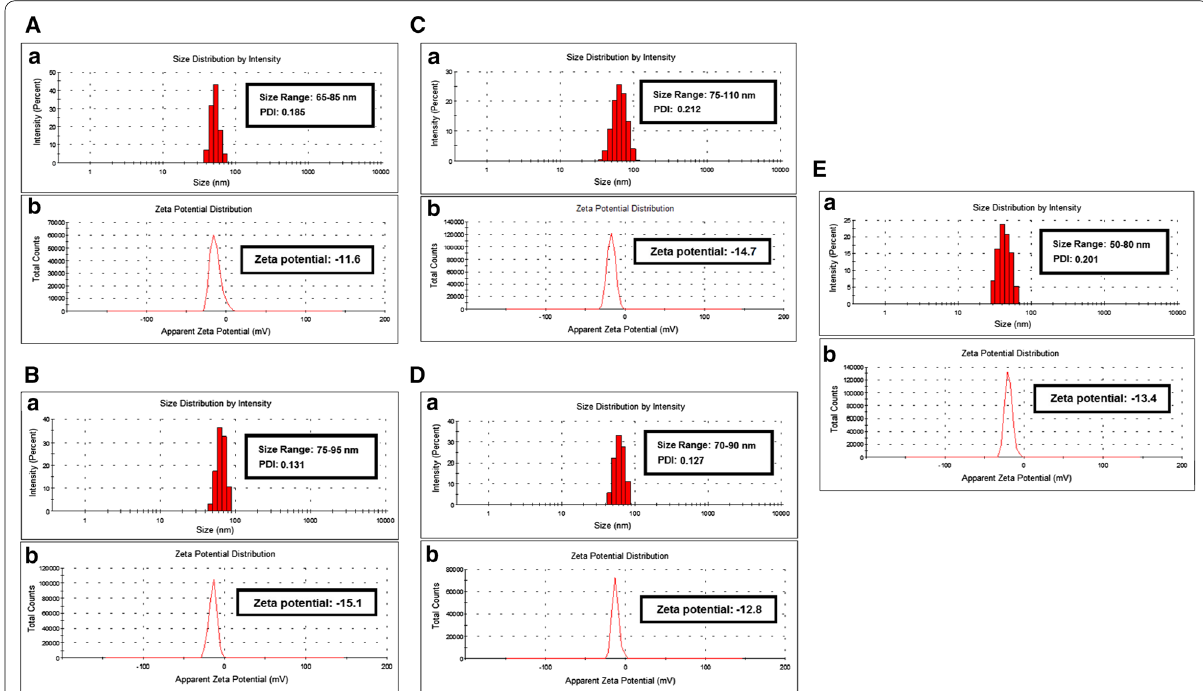
Fig. 3 Illustrating the average particle size distribution histogram and zeta potential of ZnO nanoparticle, the reducing/capping agent and various drugs used in the study where A showing particle size ( a ) and zeta potential graph ( b ) of quercetin loaded beta-cyclodextrin capped ZnO NPs (QT-ZnO-BCD NPs), B showing particle size distribution histogram ( a ) and zeta potential graph ( b ) of naringin loaded beta-cyclodextrin capped ZnO NPs (NAR-ZnO-BCD NPs), C display average particle size distribution histogram ( a ) and zeta potential graph ( b ) of ceftriaxone loaded beta-cyclodextrin capped ZnO NPs (CFT-ZnO-BCD NPs), D display particle size distribution histogram ( a ) and zeta potential graph ( b ) of ampicillin loaded beta-cyclodextrin capped ZnO nanoparticles (AMP-ZnO-BCD NPs) and E showing particle size distribution histogram ( a ) and zeta potential